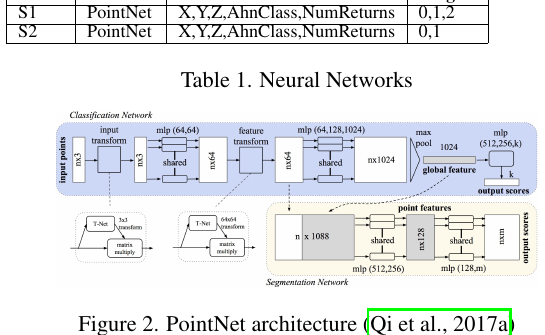
Figure 2. PointNet architecture (Qi et al.,